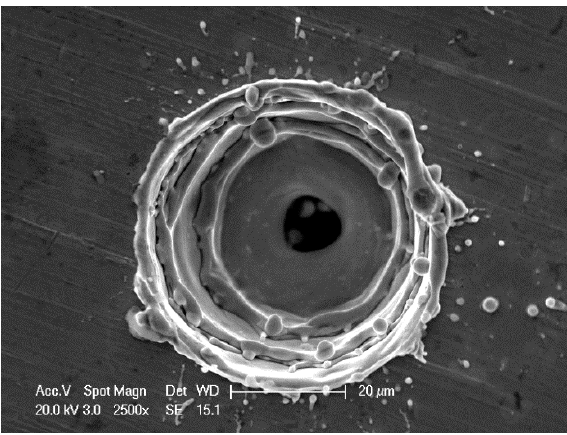
Figure 1. Environmental scanning electron microscope (ESEM) photograph of the micro-tapered hole.